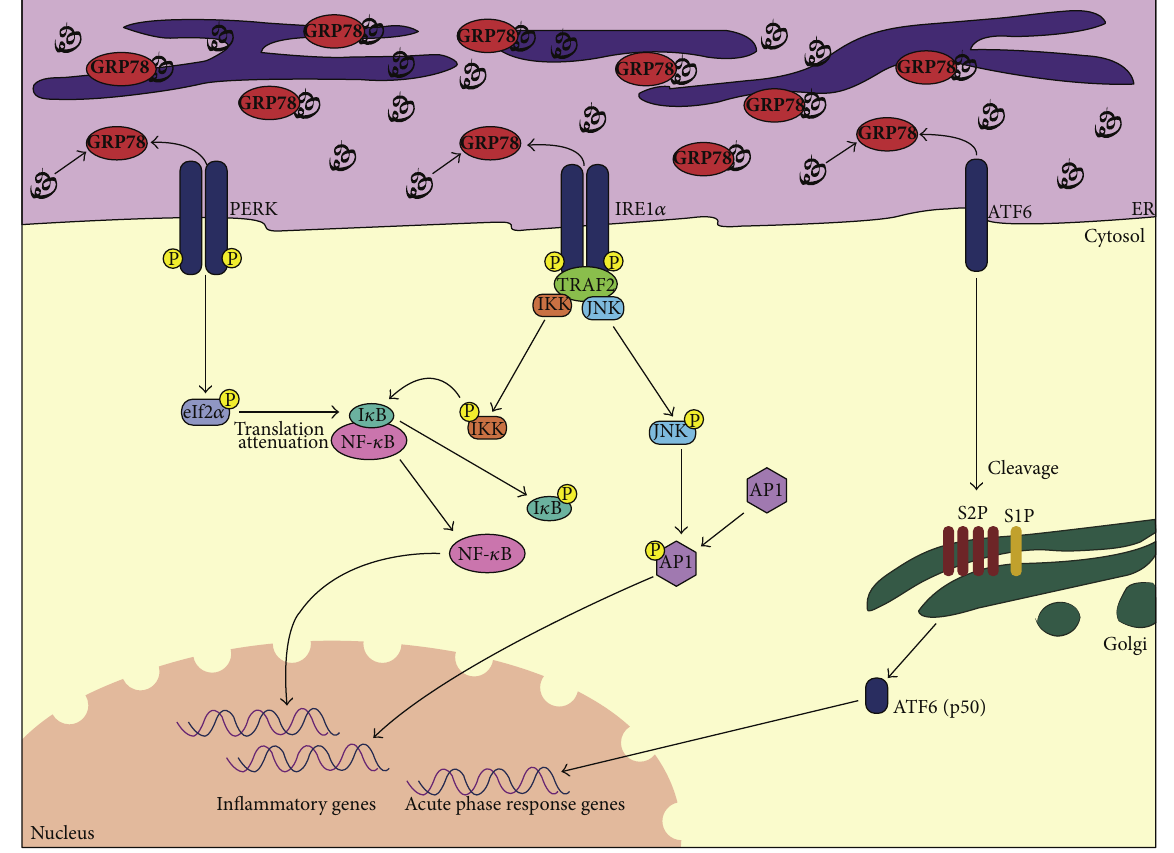
Figure 1: Overview of UPR-induced inflammatory gene transcription. The dissociation of GRP78 from the transmembrane transducers, PERK, IRE1 𝛼 , or ATF6, leads to their activation. PERK activation brought about by autophosphorylation results in the phosphorylation of eIF2 𝛼 and general translation attenuation reducing the I 𝜅 B available to bind to NF- 𝜅 B. Due to I 𝜅 B’s shorter half-life, more NF- 𝜅 B is free to enter the nucleus and activate transcription of inflammatory genes. Autophosphorylation of IRE1 𝛼 causes the cytosolic domain to associate with TRAF2. The IRE1 𝛼 -TRAF2 complex recruits IKK which phosphorylates I 𝜅 B resulting in NF- 𝜅 B activation. This complex recruits protein kinase JNK leading to phosphorylation of transcription factor AP1 as well. Upon activation, ATF6 leaves the ER and undergoes cleavage by site 1 (S1P) and site 2 proteases (S2P) in the Golgi complex. The 50-kilodalton cleavage product (p50) acts as a transcription factor in the nucleus and results in the transcriptional initiation of acute phase inflammatory response